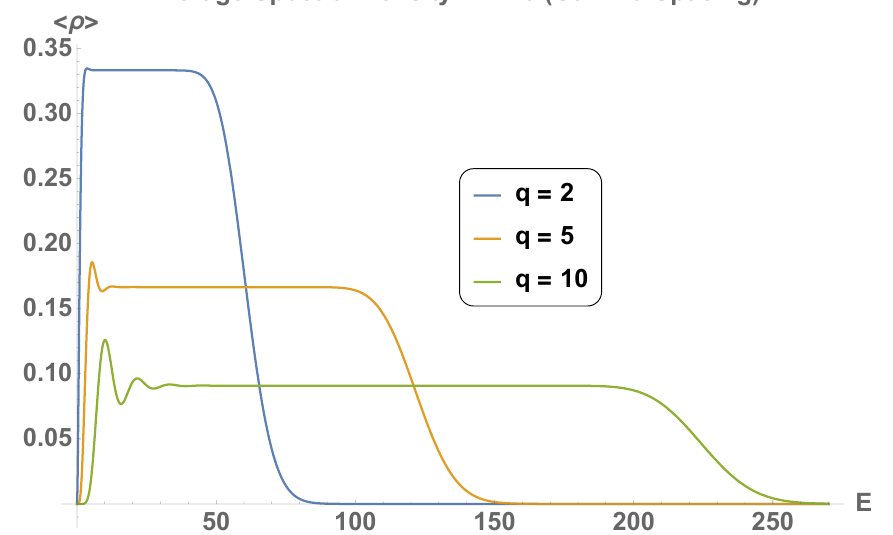
Figure 12 . The above plot depicts the averaged spectral density in eq. (3.21). We fix N = 20 and plot the density at various values of q (we set σ = 1 and E 0 = 0 ). The width the spectrum roughly scales as N ( q + 1) for N (cid:29) 1